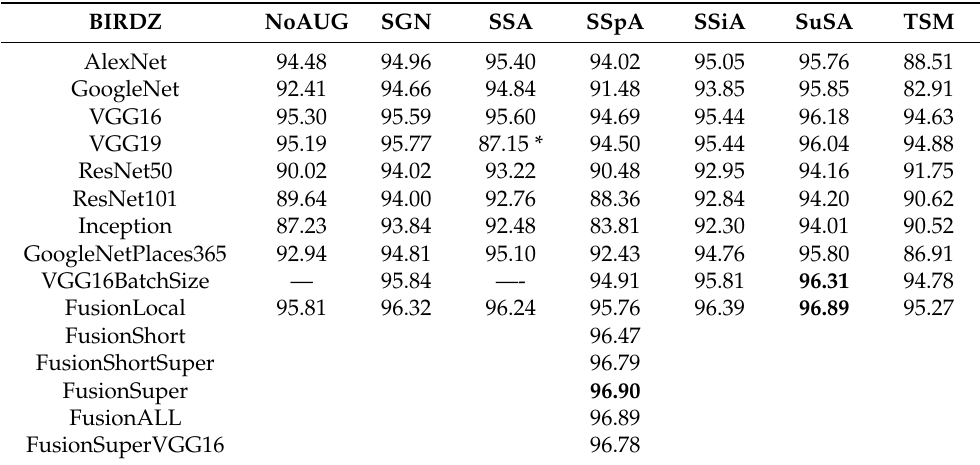
Table 3. Performance on the BIRDZ (mean accuracy over ten-split training/test set).